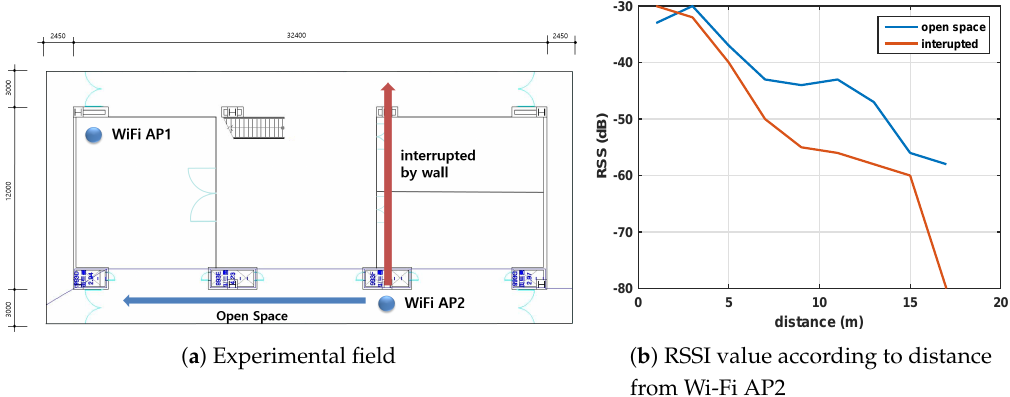
Figure 2. ( a ) Experimental floor plan and ( b ) RSSI value of Wi-Fi AP2 according to the distance.